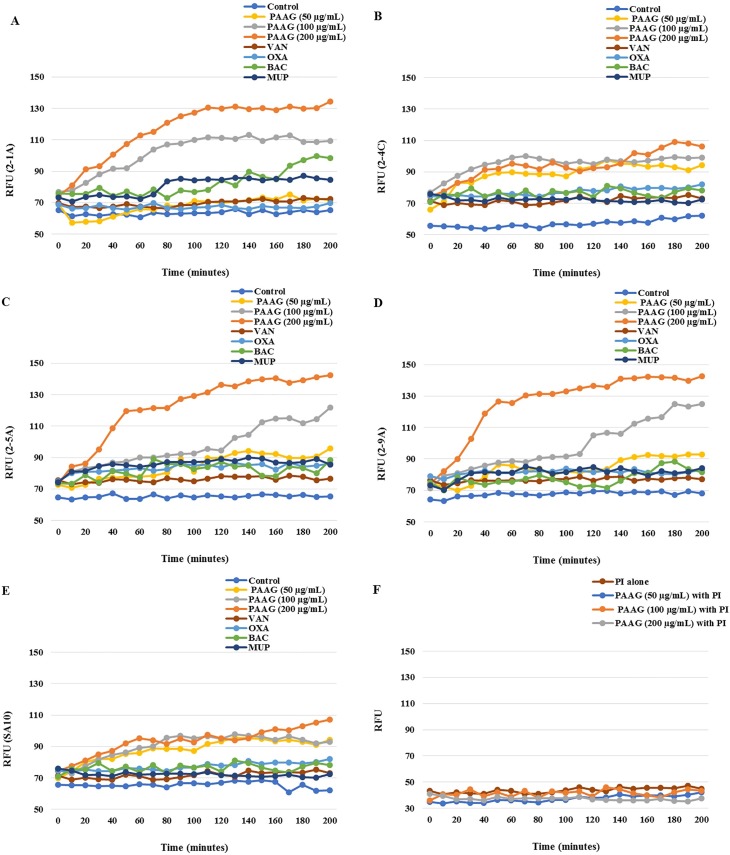
(A-F). The relative fluorescence units (RFU) measured reflects PI intercalation into bacterial DNA by 2-1A (A), 2-4C (B), 2-5A (C), 2-9A (D), SA10 (E), PI alone and PI with PAAG (F) over 200 minutes, with the addition of control, 50–200 μg/mL PAAG, 100 μg/mL of vancomycin, oxacillin, mupirocin or bacitracin respectively.